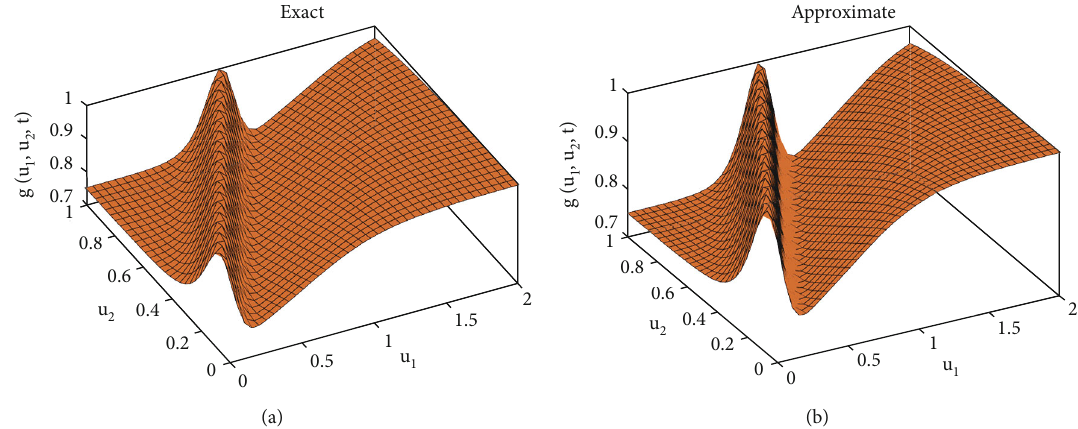
Figure 3: 3D view of the exact and approximate solution via JTDM of Example 16 for g ð u